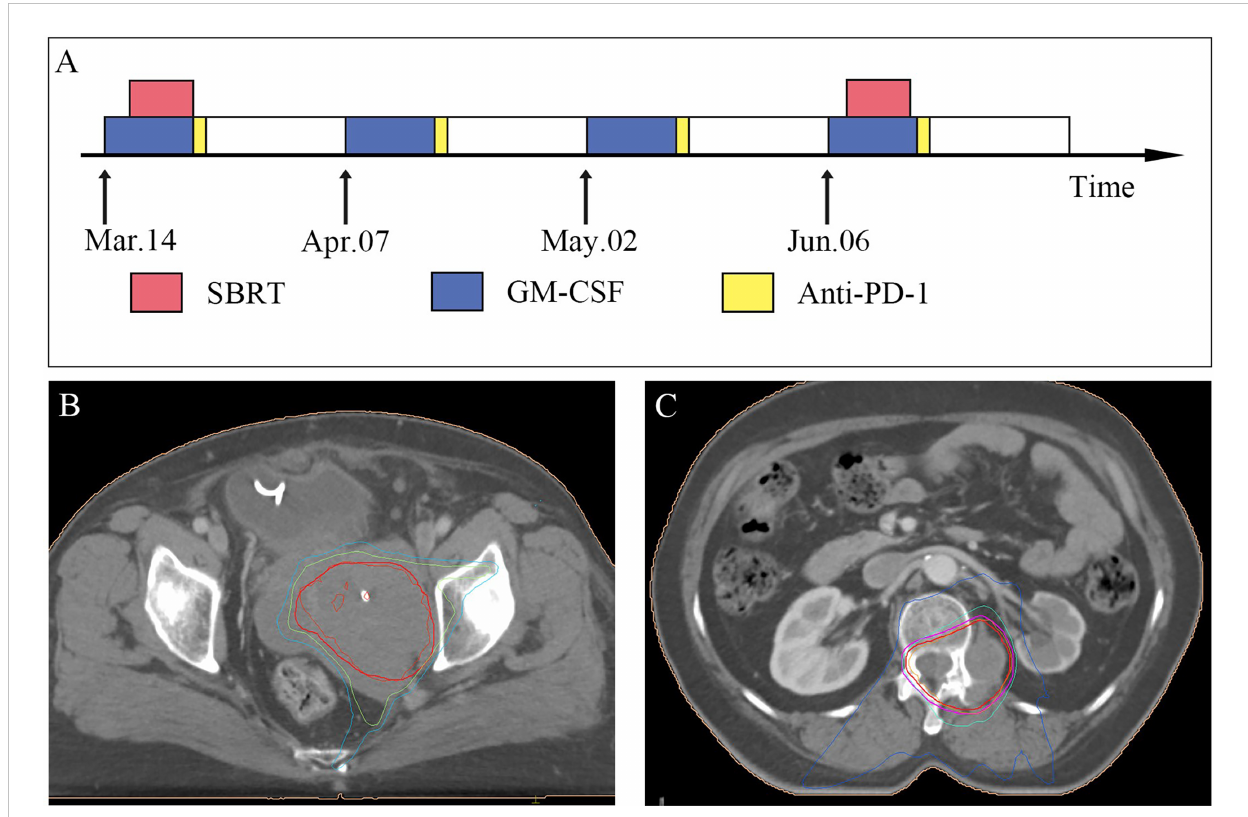
FIGURE 3 (A) The patient ’ s treatment schedule for 4 cycles. Subcutaneous injection of GM-CSF 200 mg was used on days 1-7. Immunotherapy with tislelizumab 200 mg on day 8. For the fi rst and fourth time, SBRT was performed simultaneously with GM-CSF. (B) Radiotherapy treatment plan (isodose lines: 30 Gy, 24 Gy, 20 Gy in red, green, light blue respectively). (C) Radiotherapy treatment plan (isodose lines: 22.8 Gy, 20 Gy, 11.4 Gy in orange, light blue, dark blue